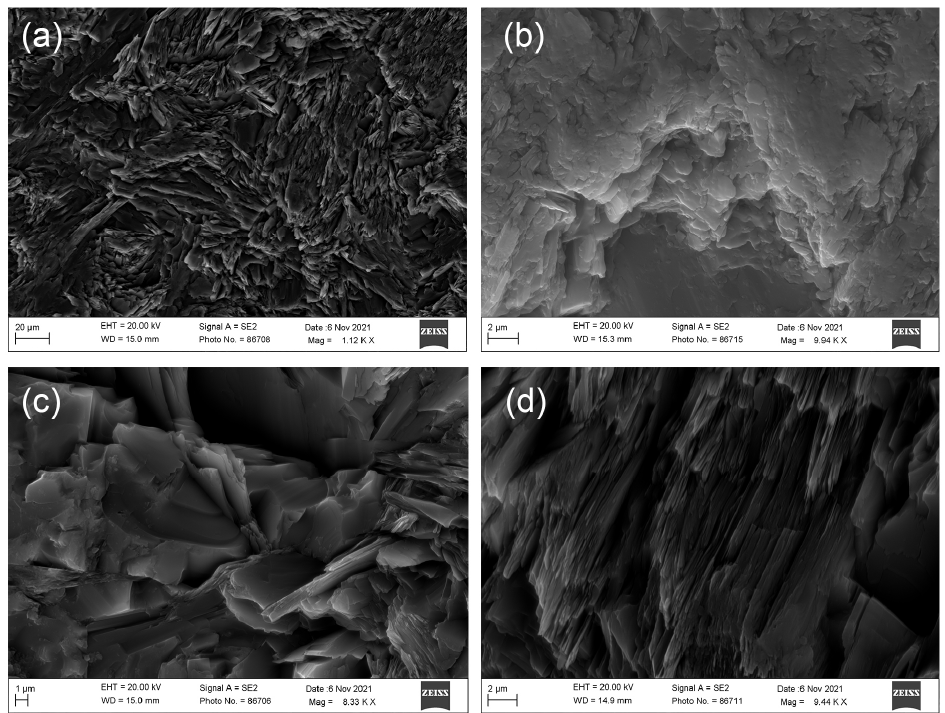
Figure 3. Scanning electron microscope (SEM) images of bluish-green serpentinite samples. ( a ) Lepidoblastic texture. ( b ) Lamellar crystallisation structure. ( c ) Curly and folded shape. ( d ) Directional arrangement of serpentine minerals.